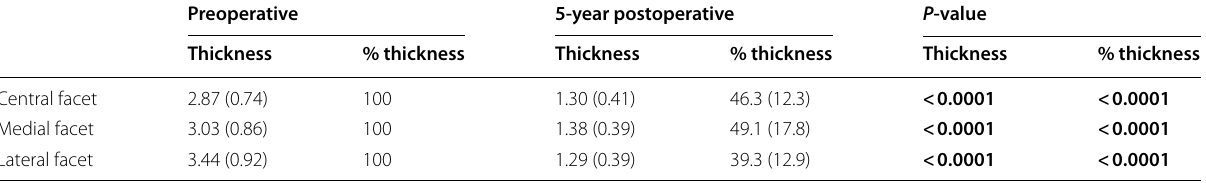
Table 5 Comparisons of the preoperative and 5-year postoperative patellar cartilage thickness and percentage cartilage thickness